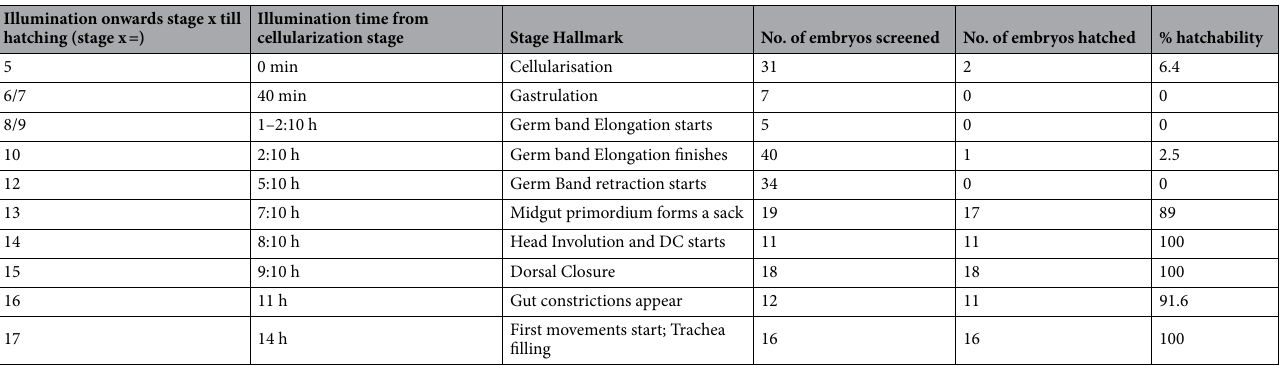
Table 2. Hatching rate of twi ::Gal4 > Opto-htl embryos illuminated from specified stages until end of embryogenesis.